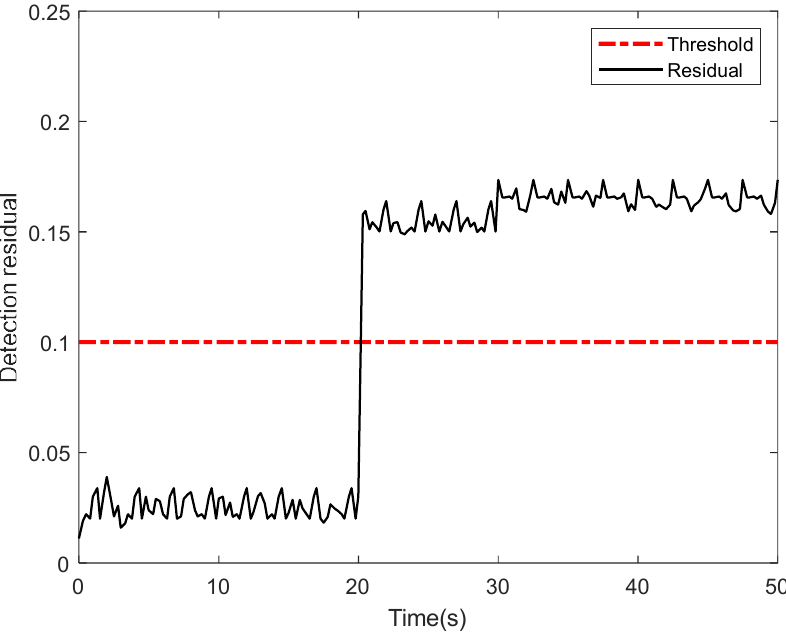
Figure 3. Detecting residual and threshold under sensor faults.